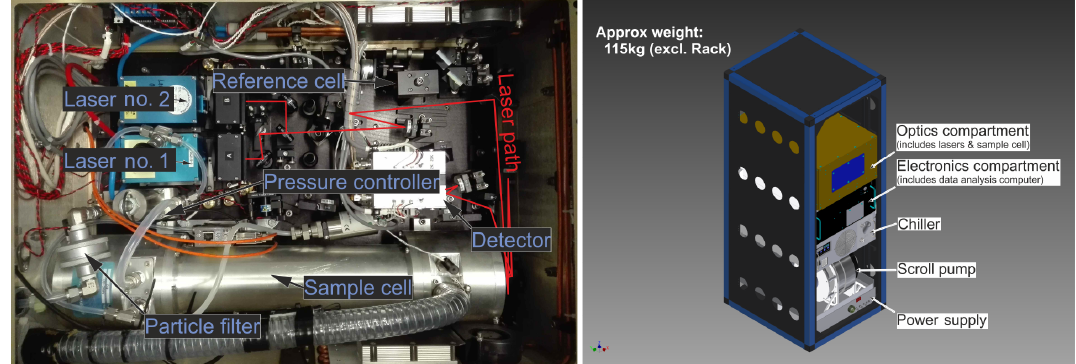
Figure 1. Top-down photograph of the optics compartment (a) . The sample cell made from aluminum along with the pressure controller and pressure transducers can be identified in the lower half. The QCL and ICL are mounted inside the blue housings to the left of the collimating Schwarzschild telescopes in the two black housings. The two detectors are mounted below the silver aluminum cases, housing the pre-amplifiers, on the right. The first detector is used for detecting both lasers after passing through the sample cell. The second detector is used for spectral referencing through an auxiliary optical path. Panel (b) illustrates the rack-mounted instrument. The figure includes solid models from Aerodyne Inc. and Solid State Cooling